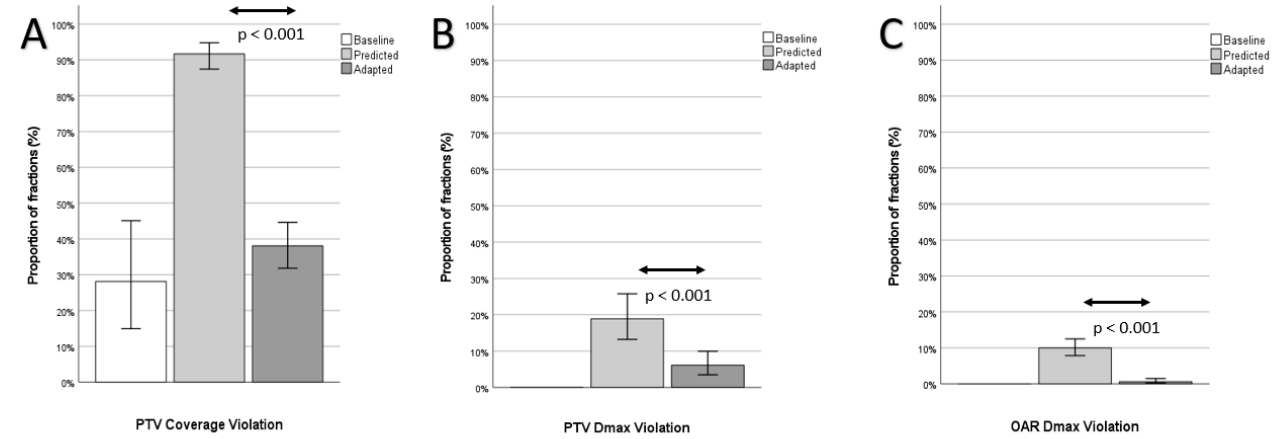
Figure 2. Planning objective violations. Proportion of fractions with one or more violation of the planning target volume (PTV; A ) coverage, PTV maximum dose (Dmax; B ) or organ at risk (OAR, C ) Dmax.